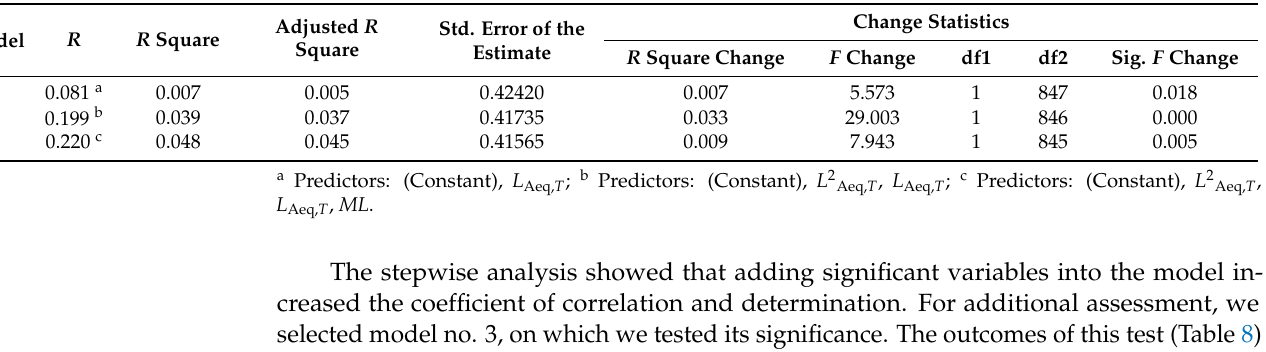
Table 7. Stepwise multiple regression and correlation analysis.